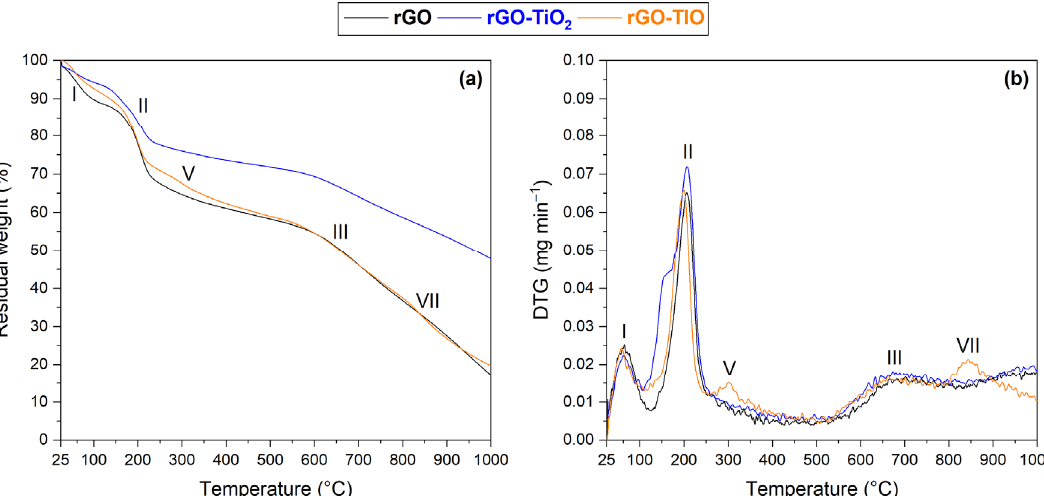
Figure 7. Thermogravimetric plots of rGO, rGO–TiO 2 , and rGO–TIO membranes: ( a ) residual weight and ( b ) DTG.